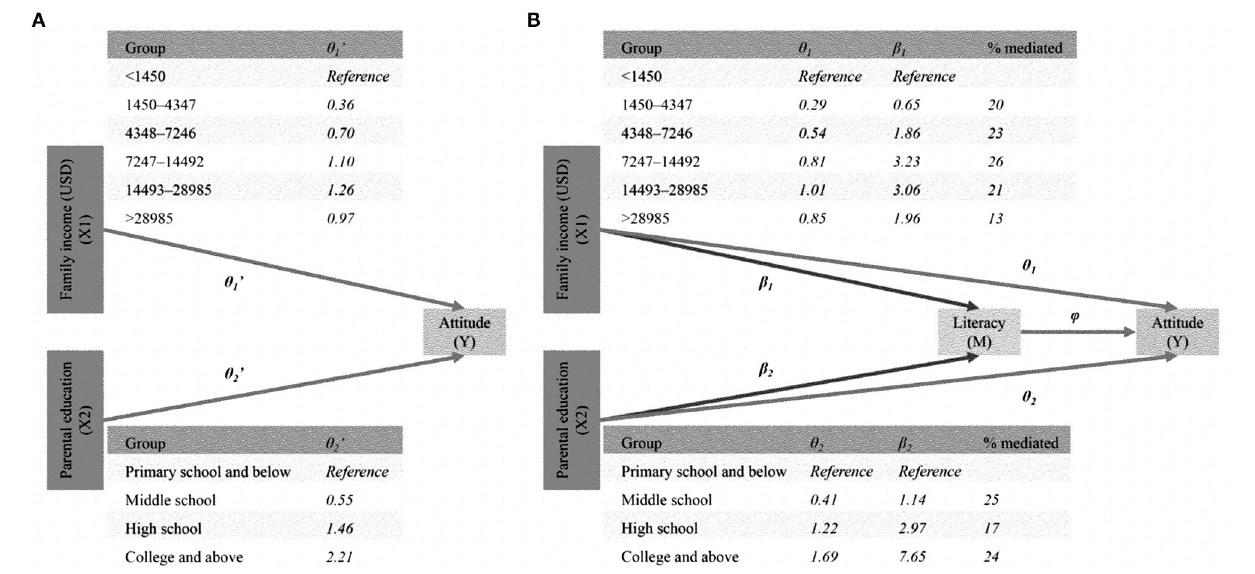
Frontiers in Public Health |